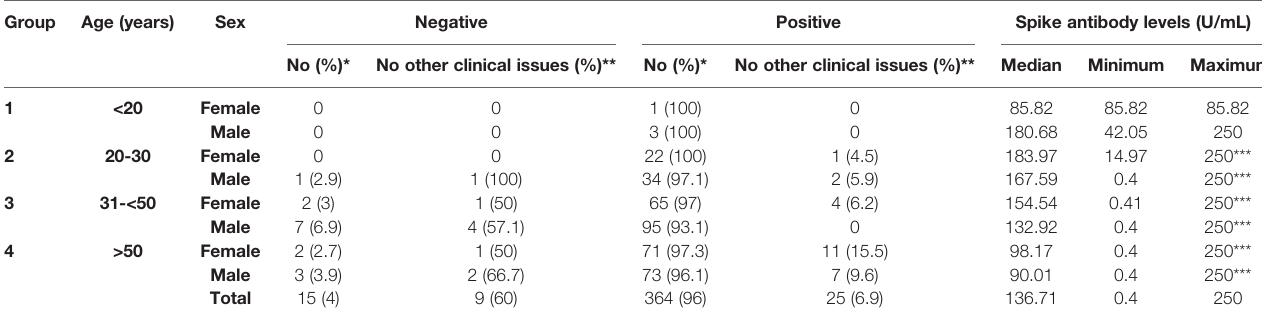
TABLE 2 | Quanti fi cation of SARS-CoV-2 S antibody positivity of individuals given 2 doses of Sinopharm vaccine. Group